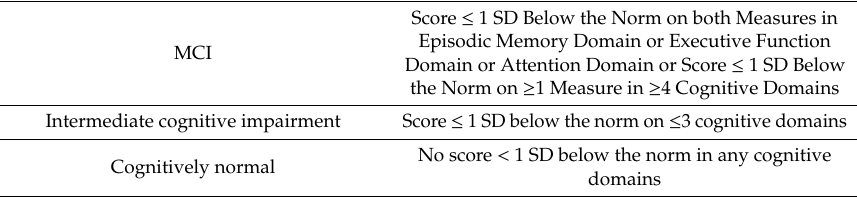
Table 2. Operationalization of MCI, intermediate, and cognitively normal